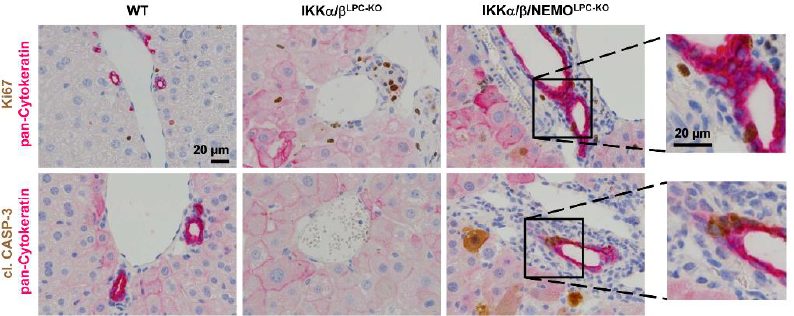
Figure 5. Increased regeneration of the biliary compartment in IKK α / β LPC-KO mice by additional deletion of NEMO. Representative immunohistochemical staining of liver sections from WT, IKK α / β LPC-KO and IKK α / β / NEMO LPC-KO mice (n = 3). (Upper panel: pan-Cytokeratin is stained pink / red and Ki67 is stained brown; lower panel: pan-Cytokeratin is stained pink / red and cl. Caspase-3 is stained